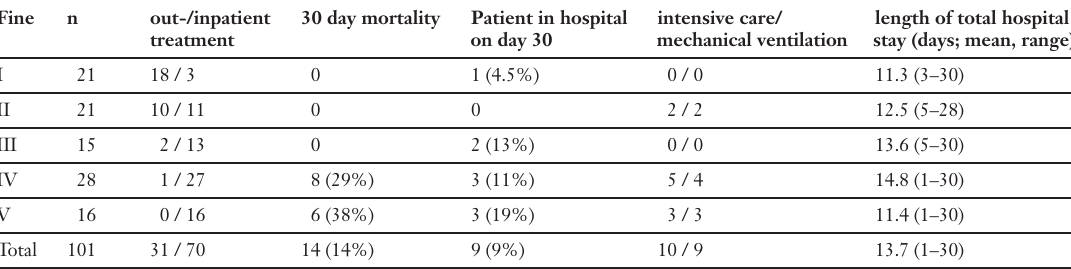
Patient treatment and outcome according to Fine risk